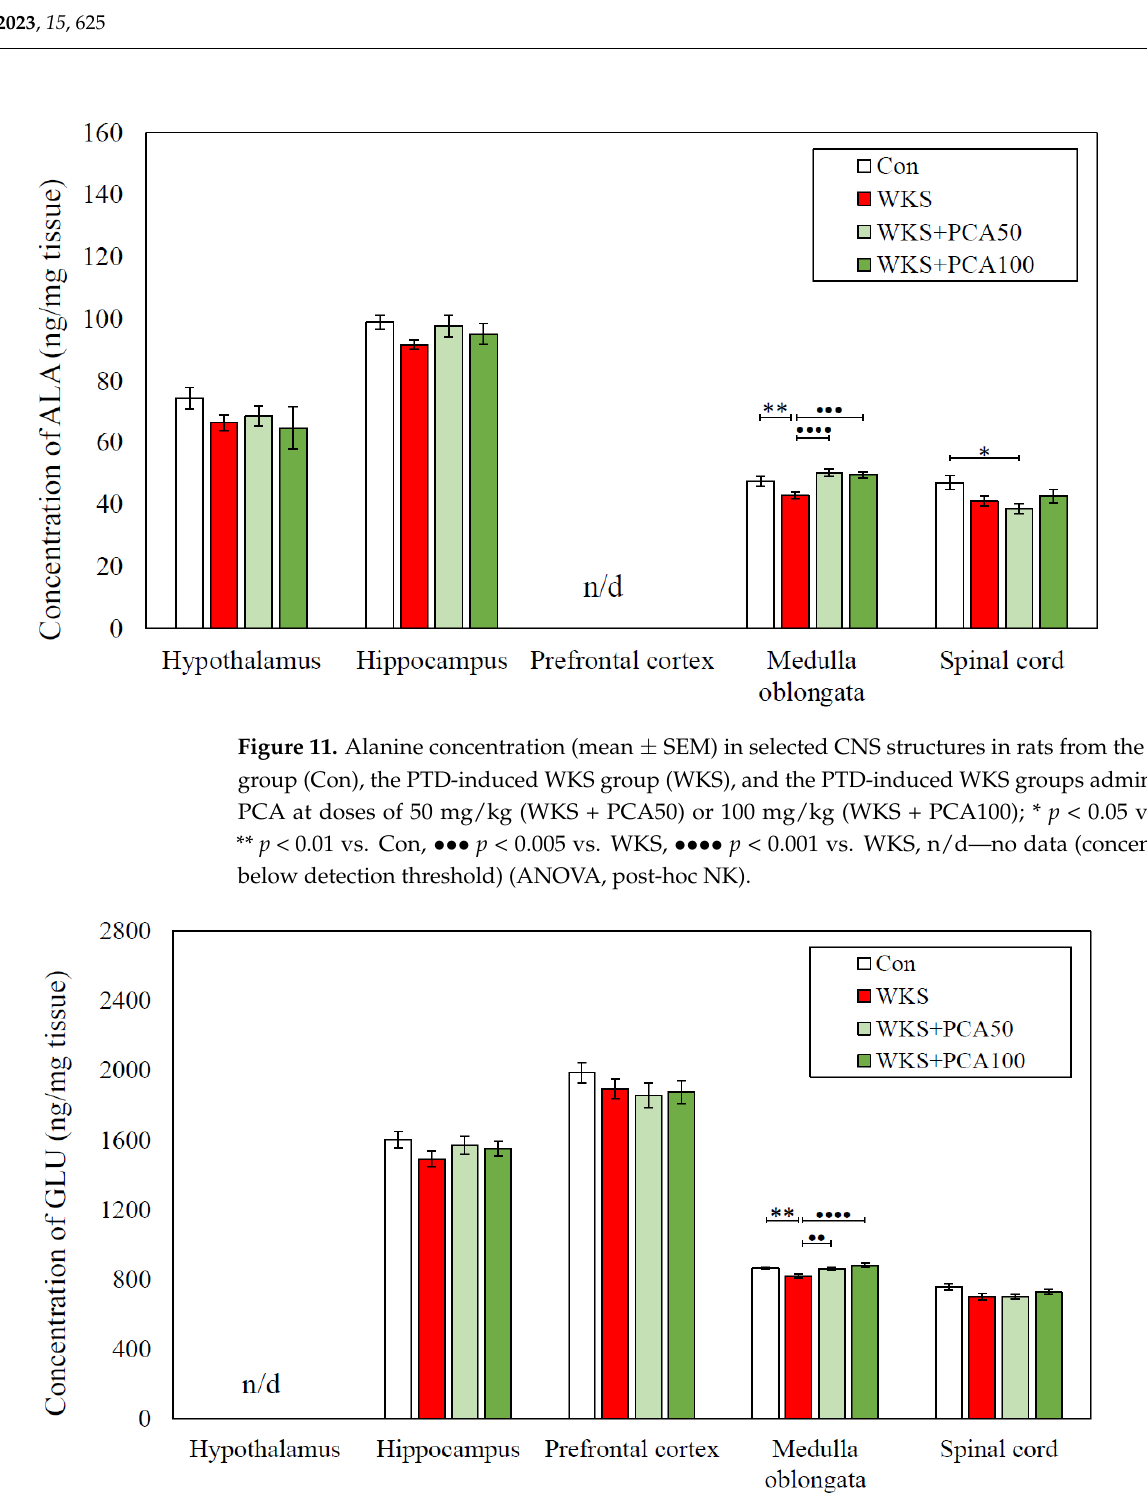
Figure 12. Glutamate concentration (mean ± SEM) in selected CNS structures of rats from the control group (Con), the PTD-induced WKS group (WKS), and the PTD-induced WKS groups administered PCA at a dose of 50 mg/kg (WKS + PCA50) or 100 mg/kg (WKS + PCA100); ** p < 0.01 vs. Con, •• p < 0.01 vs. WKS, •••• p < 0.001 vs. WKS (ANOVA, post-hoc NK).